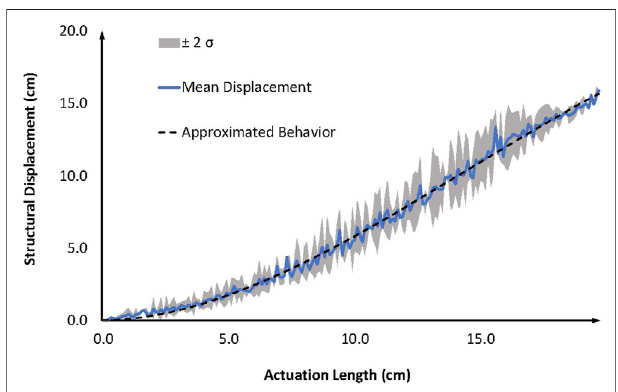
FIGURE 10 | Plot for structural displacement (cm) vs. actuation length (cm) where the continuous blue line shows the mean structural displacement (cm) obtained from the experimental study. The gray region represents the area enclosed under two standard deviations on either side of the mean structural displacement. The discontinuous black line depicts the approximated behavior for change in length of the structure (cm) against actuation length (cm).